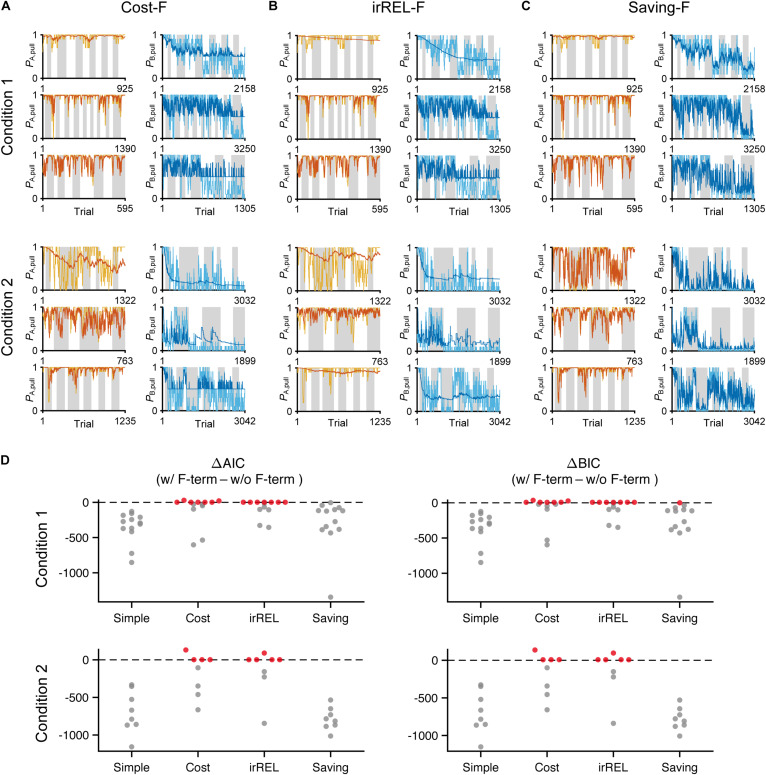
The saving-F model well-explains the pull-choice probability and trial-by-trial fluctuation. (A–C) Six representative predicted pull-choice probabilities of the models in tone A (left) and B (right) trials in conditions 1 (top three rows) and 2 (bottom three rows). Orange and cyan traces represent the 10-trial moving-average of the actual pull-choice (the same as in Figure 2). Red and blue traces represent the predicted pull-choice probability in cost-F (A), irREL-F (B), and saving-F (C) models. (D) Differences in AIC (ΔAIC, left) and BIC (ΔBIC, right) between the models (simple, cost, irREL, or saving) with and without introduction of αf as a free parameter (w/F-term–w/o/F-term). Top, condition 1. Bottom, condition 2. Each dot indicates a single mouse. A negative value indicates that the model prediction with αf was better than that without it. Red dots indicate positive values.